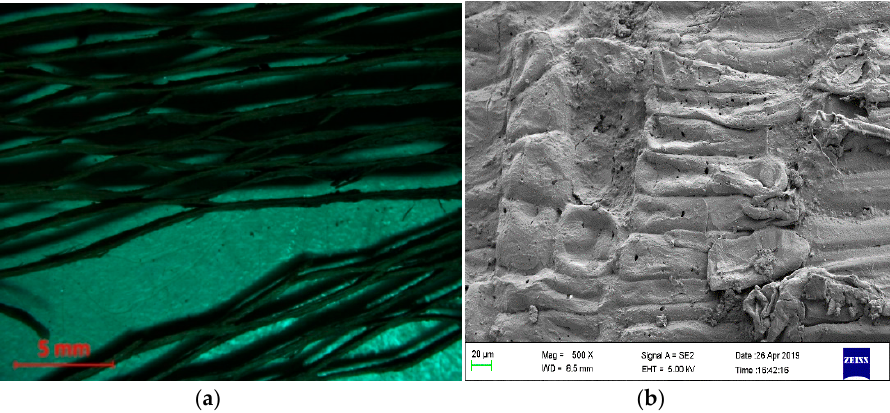
Figure 4. ( a , b ) Optical and SEM representation of treated network structure pawpaw fiber. Fibers 2020 , 8 , x FOR PEER REVIEW